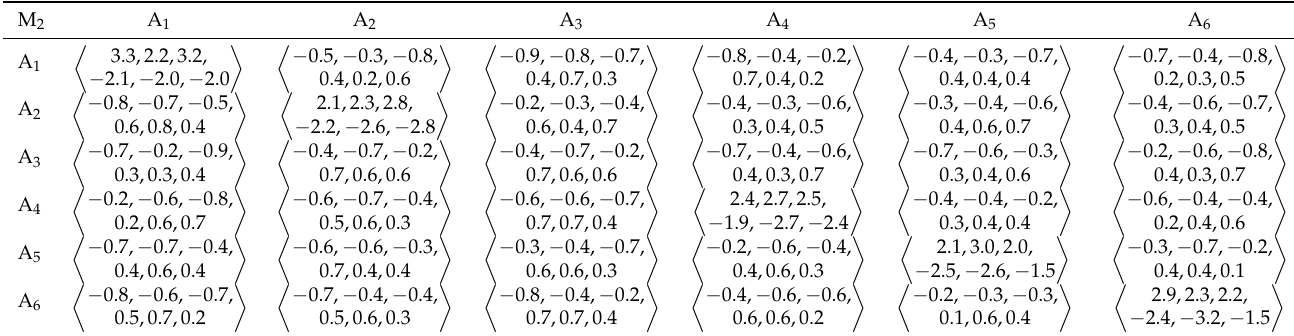
Table 13. Elements of the Laplacian matrix of the BSVNDG, D 2 .